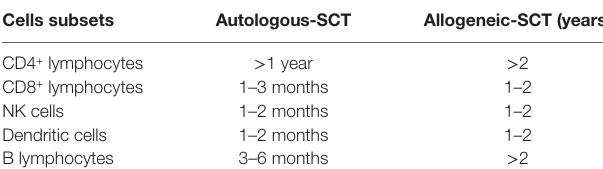
TABLe 1 | Time line of immune reconstitution of immune cells after autologous and allogeneic-SCT (7, 11–17). Cells subsets